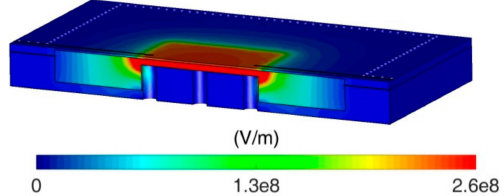
Figure 5. Electric field distribution of the cavity at resonance.